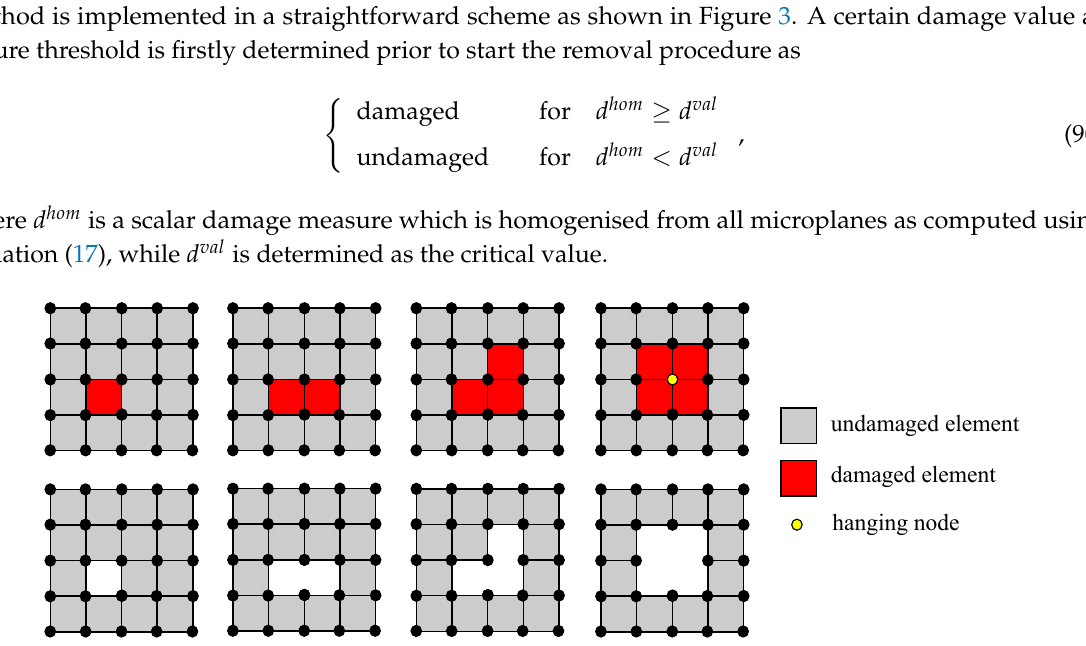
Figure 3. Illustration of adaptive element erosion